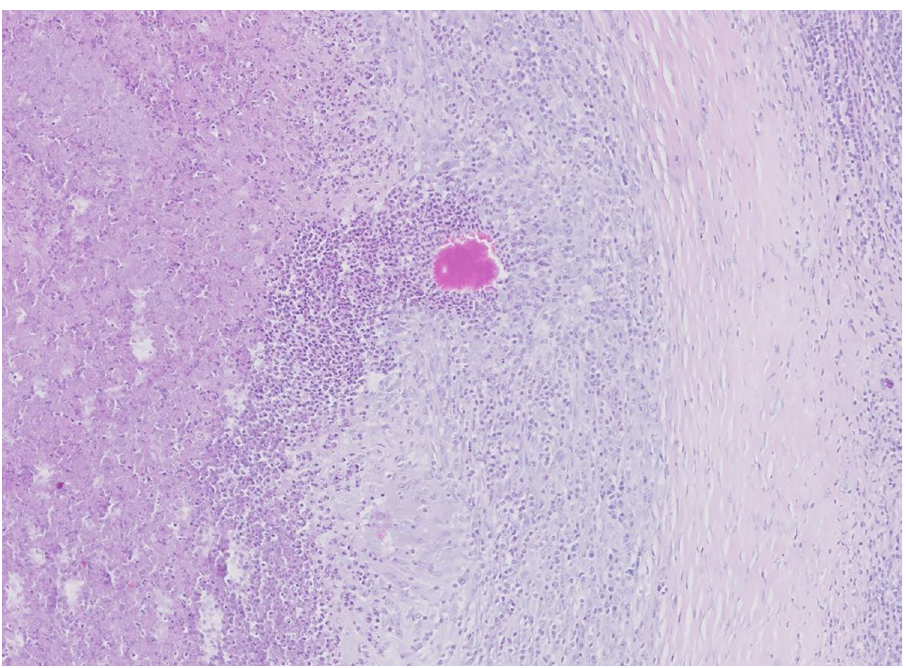
Fig 5. Histopathologic examination of mandibular lymph node with Splendore - Hoeppli-like material. Multifocal to coalescing granuloma formation can be seen. Granulomas consist of a central area of necrosis surrounded by a thick rim of partially epithelial macrophages and sometimes multinucleated giant cells. A visible demarcation formed by collagen-rich connective tissue is also present. Splendore - Hoeppli material can be observed, represented by a radiating club-shaped eosinophilic material.